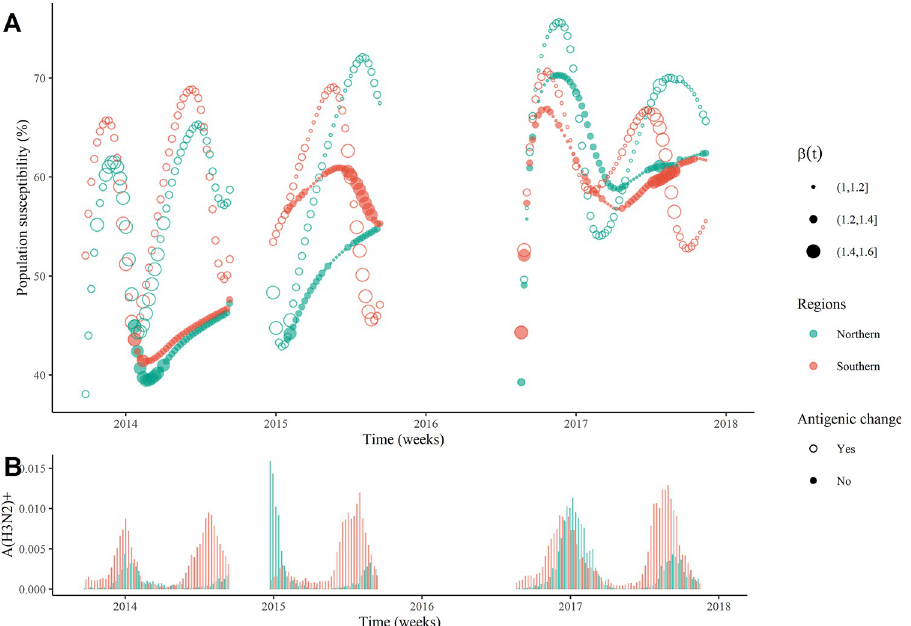
Fig 2. Dynamic changes of population susceptibility, seasonal transmission rates (A) and incidence of influenza A(H3N2) (B) in the selected northern (green) and southern (red) regions of China. Based on the maximum likelihood estimations in the meta-population model for the 2013/2014, 2014/2015, and 2016/2017 influenza seasons, the population susceptibility under two scenarios (hollow circles for the situation with the antigenic change and solid circles for the one without the antigenic change) were obtained. The size of points in the top panel represents the average of estimated seasonal transmission rates ( β ( t )) for influenza A(H3N2) across